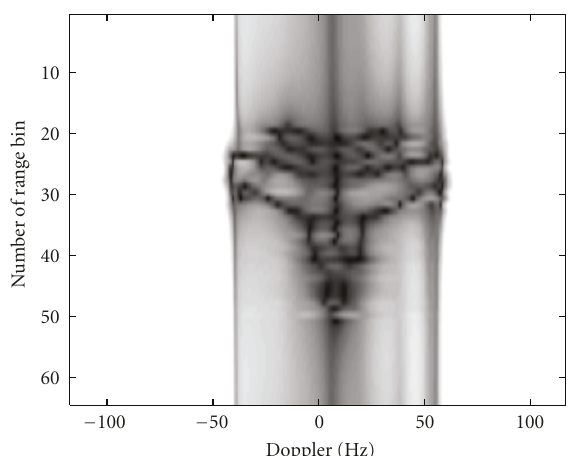
Figure 8: ISAR image obtained by applying the Capon spectral estimator to the simulated data.